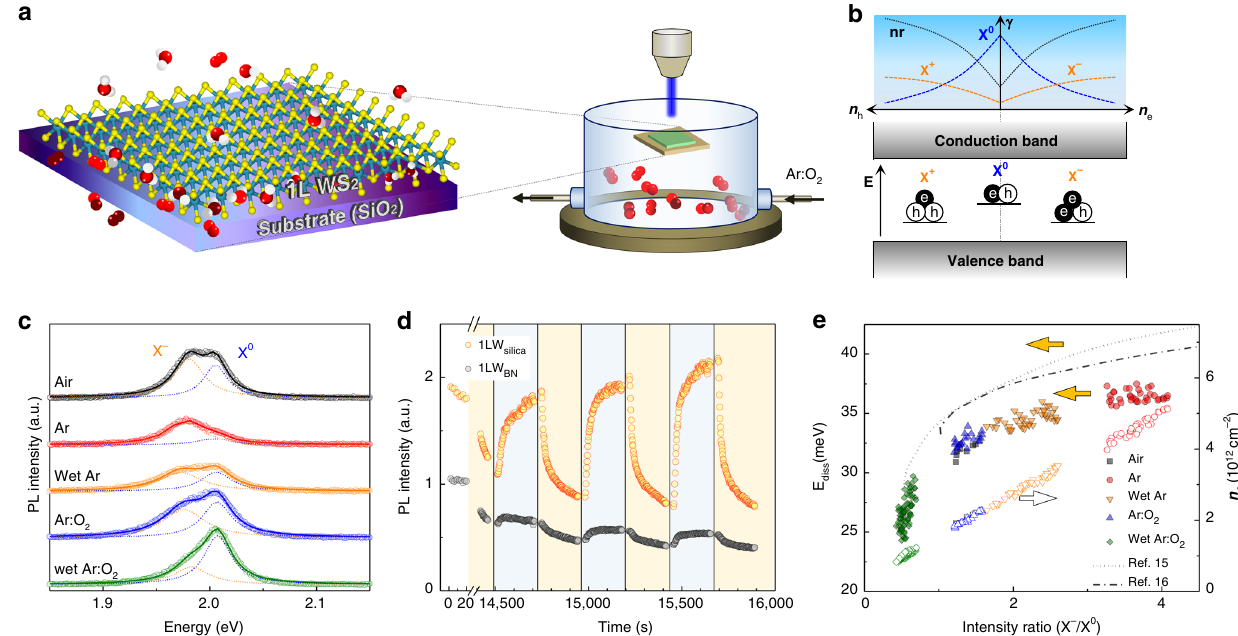
Fig. 1 Chemically modulated ionization of excitons. a In situ optical measurements of single-layer (1L) WS 2 supported on SiO 2 (1LW silica ) located in a controlled gaseous environment. The scheme illustrates 1LW silica interacting with O 2 and water in a redox reaction. b Electronic energy bands of WS 2 with neutral (X 0 ) and charged (X + and X − ) excitonic states (bottom panel); schematic representation of their radiative and nonradiative (nr) decay rates ( γ ) given as a function of charge density ( n e and n h ) (ref. 14 ) (upper panel). c Photoluminescence (PL) spectra of WS 2 in various gas environments. Solid lines are double Lorentzian fi ts representing X 0 and X − . Relative humidity for wet gases was 45%. d Time-lapse measurements of PL intensity of 1LW silica and 1LW BN in response to changes in gas environments: ambient air (white box), Ar (yellow box), and Ar:O 2 = 4:1 (blue box). e Equivalence between chemical ( fi lled symbols) and electrical (lines, refs. 15,16 ) modulations of charge density in WS 2 , where trion dissociation energy ( E diss ) in the left ordinate was given as a function of PL intensity ratio (X − /X 0 ). The electron density ( n e ) in the right ordinate (open symbols) was determined for the fi lled symbols according to the mass action law for excitons and trions (Supplementary Note